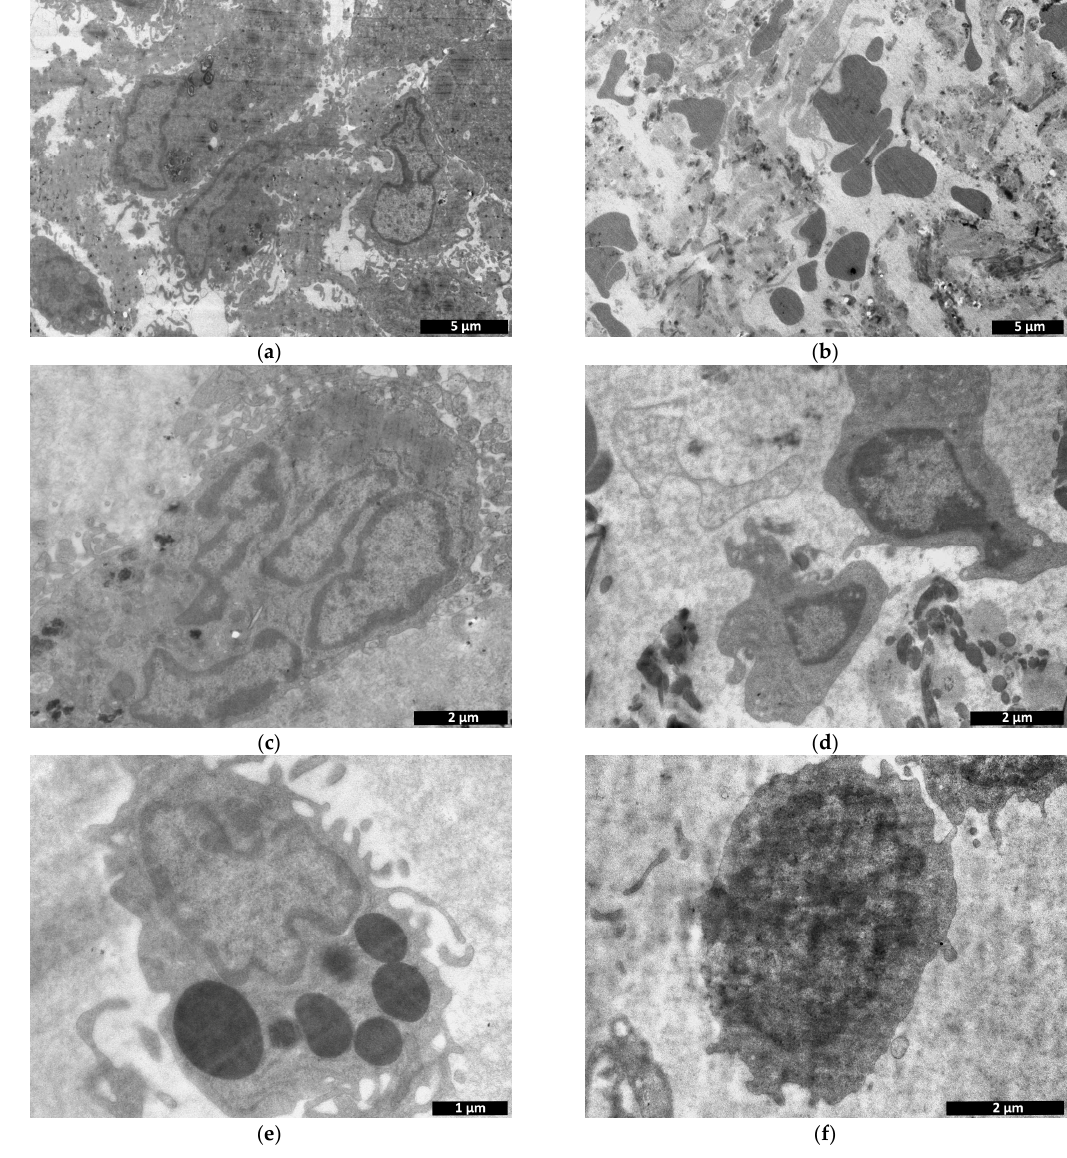
Figure 12. Comparison of experimental—cell-containing scaffolds ( a , c , e ) and controls—cell- containing collagen matrices ( b , d , f ): transmission microscopy, day 3. ( a )—fibroblastic differon cells; ( b )—erythrocytes in the intercellular space; ( c ) multinucleated cell; ( d )—cells of fibroblastic origin; ( e )—scaffold phagocytosing cell; ( f )—lymphocyte. At the same time, the number of cells observed in the field of view for the control specimens was four times lower compared to the experimental specimens (Figure 11). Along with cells of fibroblastic origin (Figure 12d), a large number of erythrocytes (Figure 12b), single lymphocytes (Figure 12f) and macrophages were found. All this may evidence a reduced rate of matrix biodegradation compared to the CCS samples.